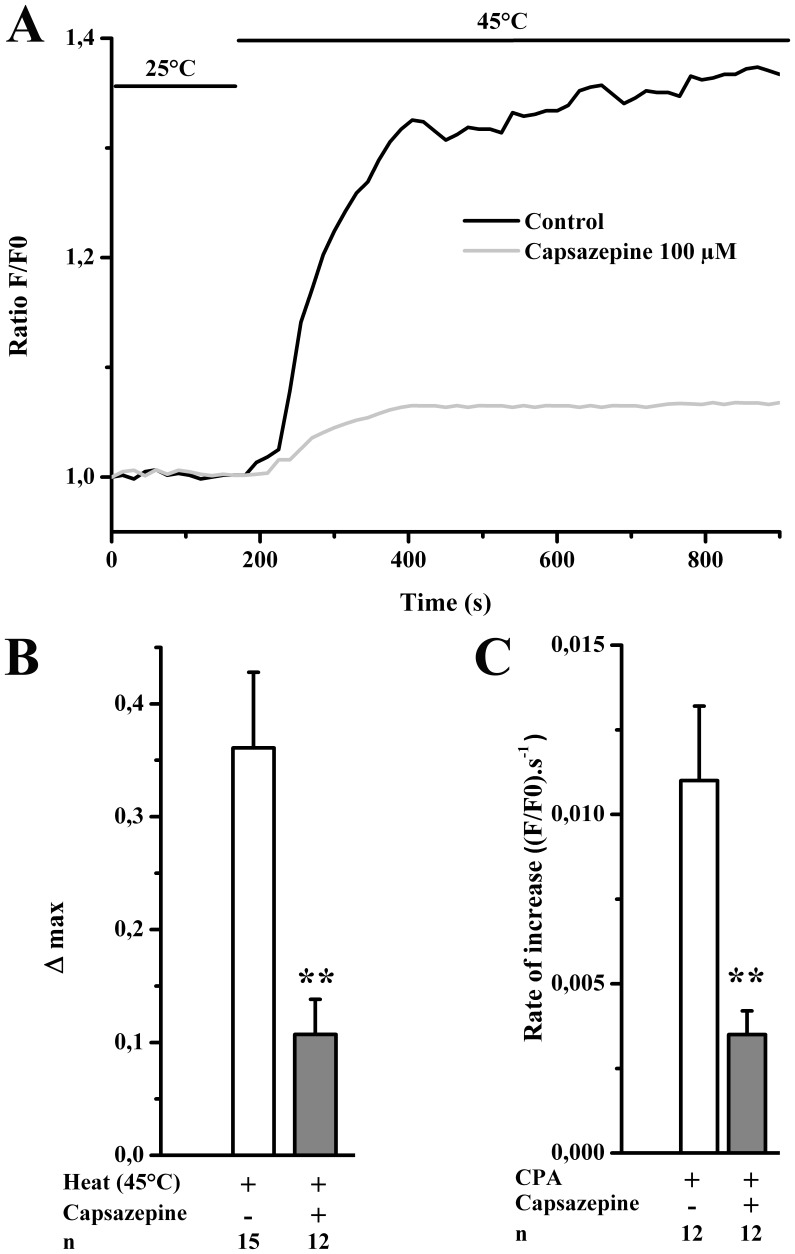
Calcium release induced by physiological activation of TRPV1 in FDB isolated fibers.(A) Time course of cytosolic Ca2+ concentration in Fluo-4 loaded cells in response to heat. The temperature of external Ca2+-free solution was increased from 25°C to 45°C (as depicted by horizontal bars on the top). Experiments were performed with or without capsazepine pre-treatment (100 µM during 25 min). (B) Cumulative data of the heat effect on SR Ca2+ release in control conditions or after capsazepine pre-treatment. (C) Cumulative data of the rate of SR Ca2+ release evoked by CPA (25 µM) in control conditions and after TRPV1 inhibition by capsazepine. Results are expressed as means ± S.E.M. T-tests were performed by paired samples: **p<0.06.